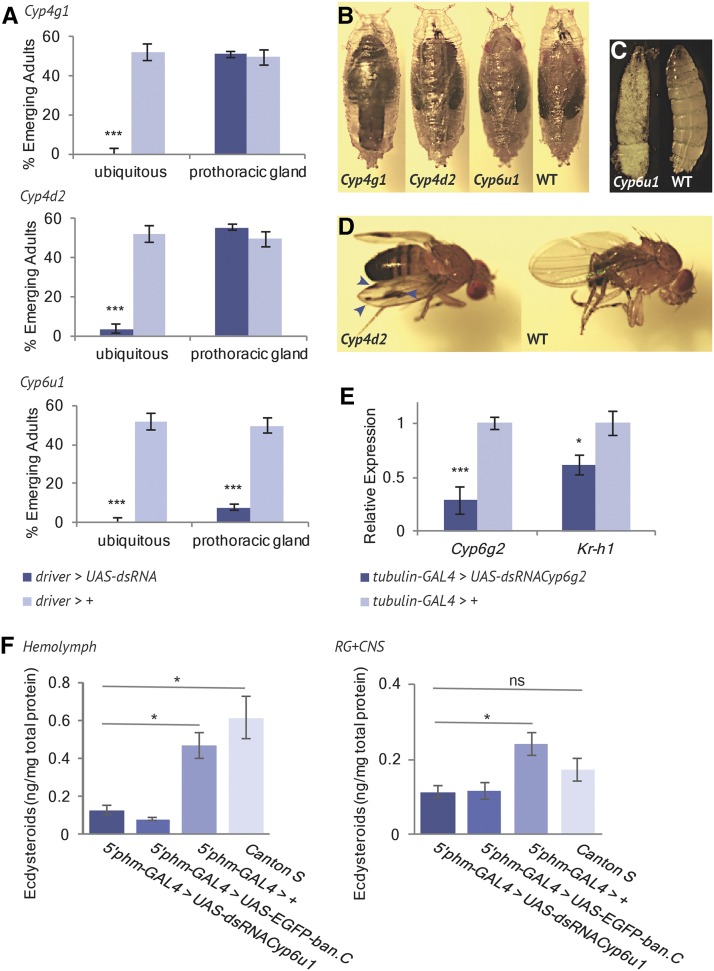
RNAi knockdown of RG-enriched cytochrome p450s. (A) Cytochrome p450s were knocked down ubiquitously (tubulin-GAL4), and with a PG-specific driver (5′phm-GAL4), and the resulting progeny scored for viability (n > 250). Each bar represents mean ± SEM. Significance was calculated using a Student’s t-test (*** P < 0.0001). (B, C) Representative pupae and larvae at the time of lethality and equivalent wild-type individuals. Ubiquitous knockdown is shown for Cyp4g1 and Cyp4d2. PG-specific knockdown is shown for Cyp6u1. (D) Adults that survived ubiquitous Cyp4d2 knockdown had variable, asymmetrical melanization on their wings (arrows). (E) qPCR reveals significantly lowered levels of Kr-h1, a juvenile hormone primary response gene, and Cyp6g2 transcripts in Cyp6g2 knockdown larvae. Significance was calculated using a Student’s t-test (* P < 0.05, *** P < 0.0001). (F) Quantity of ecdysteroids in the hemolymph and RG-CNS complexes of wandering third instar larvae is severely reduced in Cyp6u1 PG-RNAi larvae. Bars represent the mean ± SEM of three independent samples. Significance was calculated using a Student’s t-test (* P < 0.05).